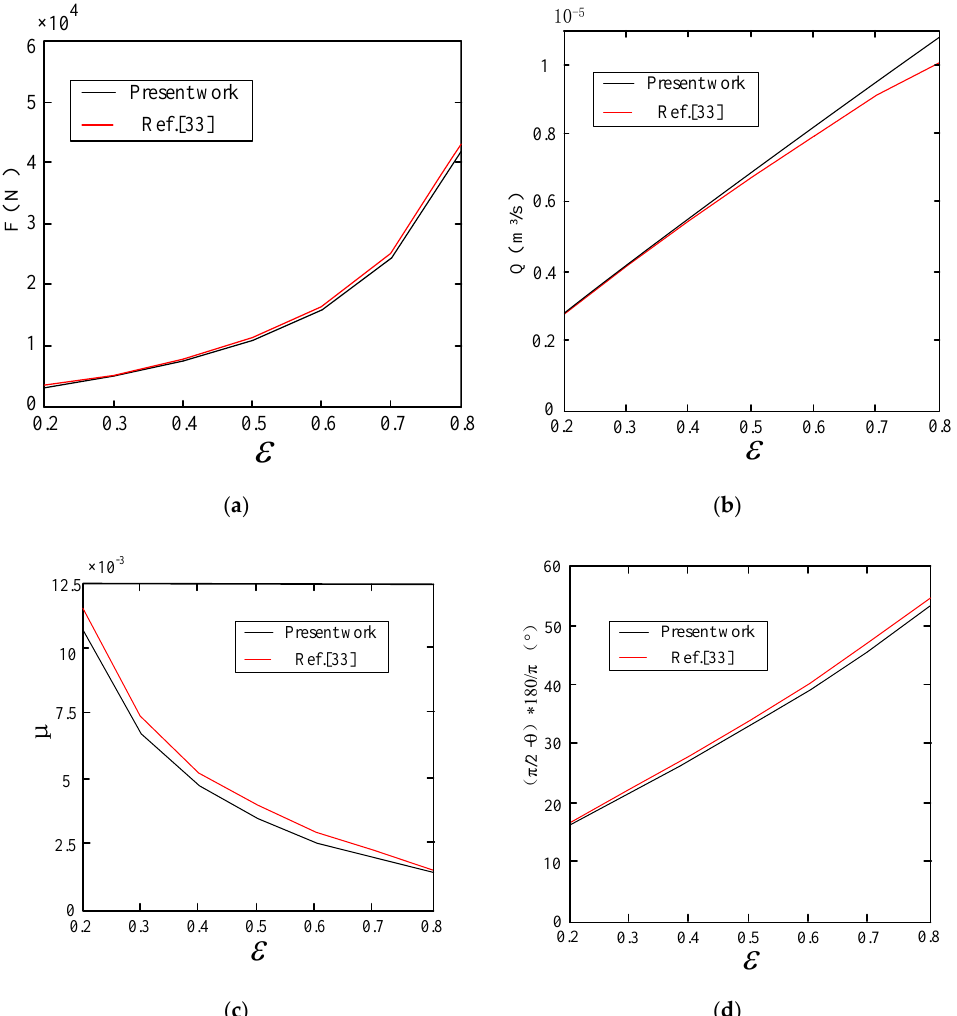
Figure 3. Comparison of the load carrying capacity ( a ), end leakage flow rate ( b ), frictional coefficient ( c ) and attitude angle ( d ) from [33] and the present analysis.